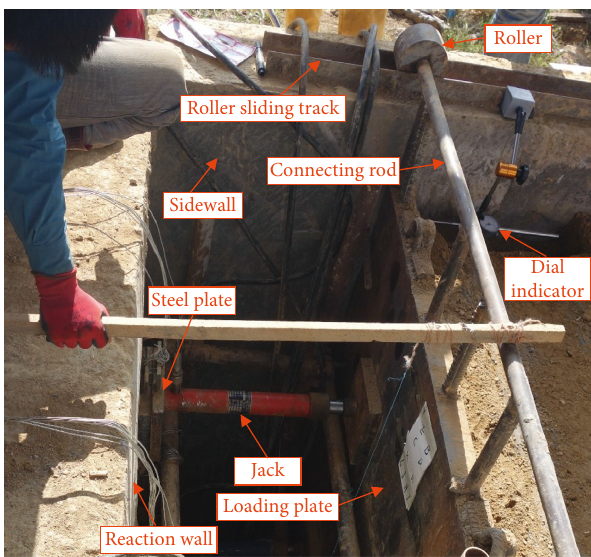
Figure 4: The connection figure between the jack and the loading plate.